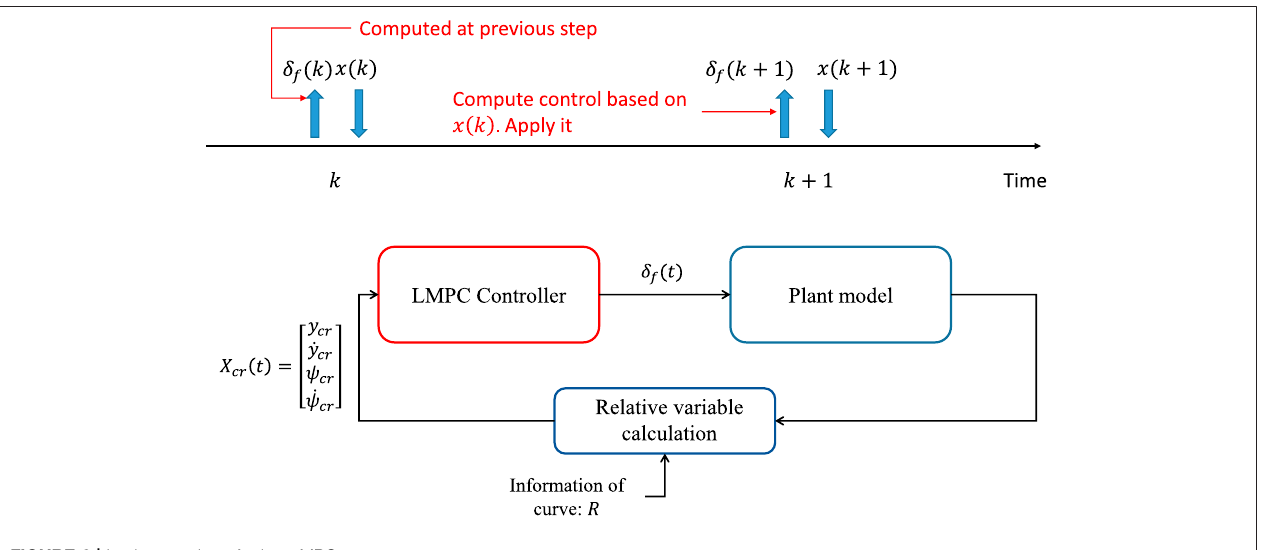
FIGURE 2 | Implementation of robust MPC.